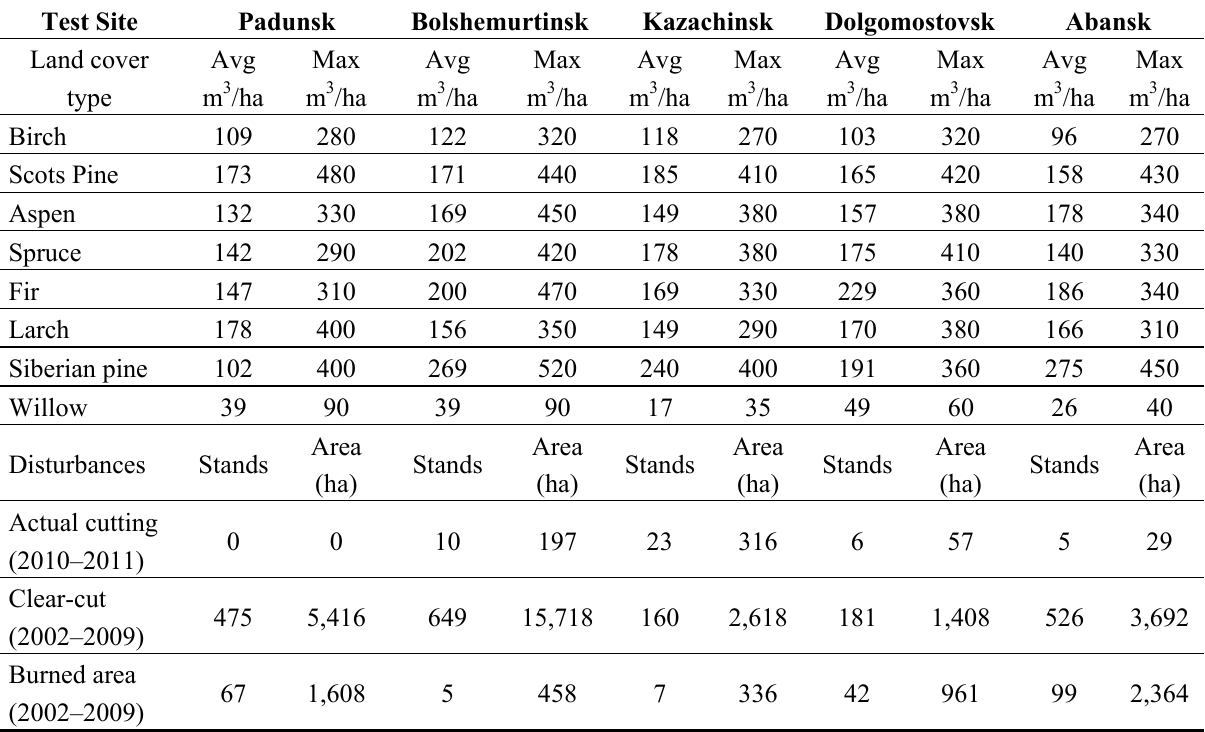
Table 3. Forest Inventory statistics for local test sites in Central